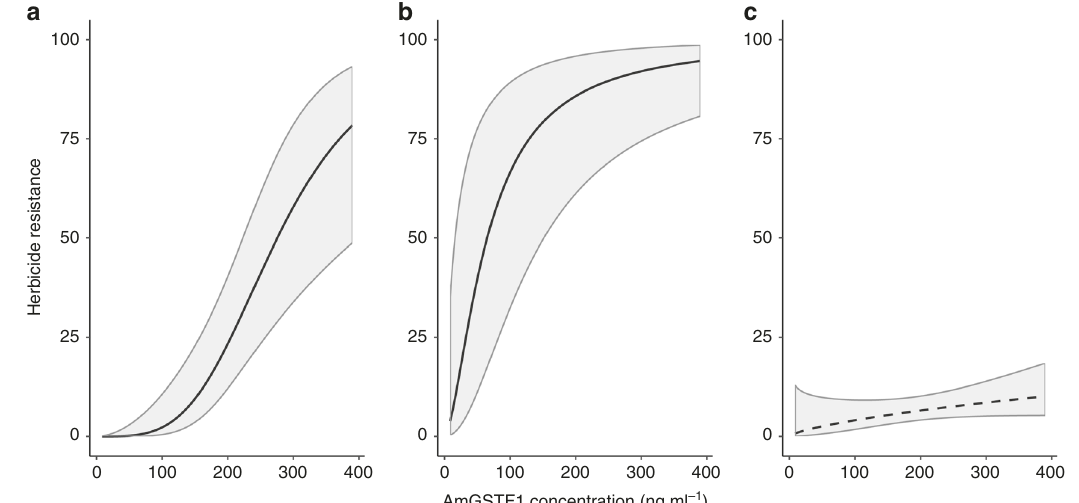
Fig. 3 Modelled relationship between population-level phenotypic herbicide resistance and the protein biomarker AmGSTF1 for the generalist NTSR mechanism. X -axis shows the foliar concentration of the Am GSTF1 protein, while Y -axis represents herbicide resistance as the proportional (%) survival of individuals for ( a ) the ‘ SU ’ herbicide mesosulfuron, ( b ) the ‘ Fop ’ fenoxaprop and ( c ) the ‘ Dim ’ cycloxydim. Fitted lines show the mean predicted relationship following mixed model analysis given in Supplementary Table 2, with shaded regions representing the estimated 95% con fi dence interval of the prediction. The modelled response variable was the proportional survival of individuals ( n = 18) over all doses of the tested herbicide. Terms for the target-site resistance frequency, Am GSTF1 concentration and their interaction were included as fi xed factors, with each model containing random effect terms for the population ID and herbicide dose. Solid black lines are used for signi fi cant relationships in ( a ) ( p ≤ 0.001) and ( b ) ( p ≤ 0.001), while a dashed line is used where the relationship was non-signi fi cant in ( c ) ( p = 0.10